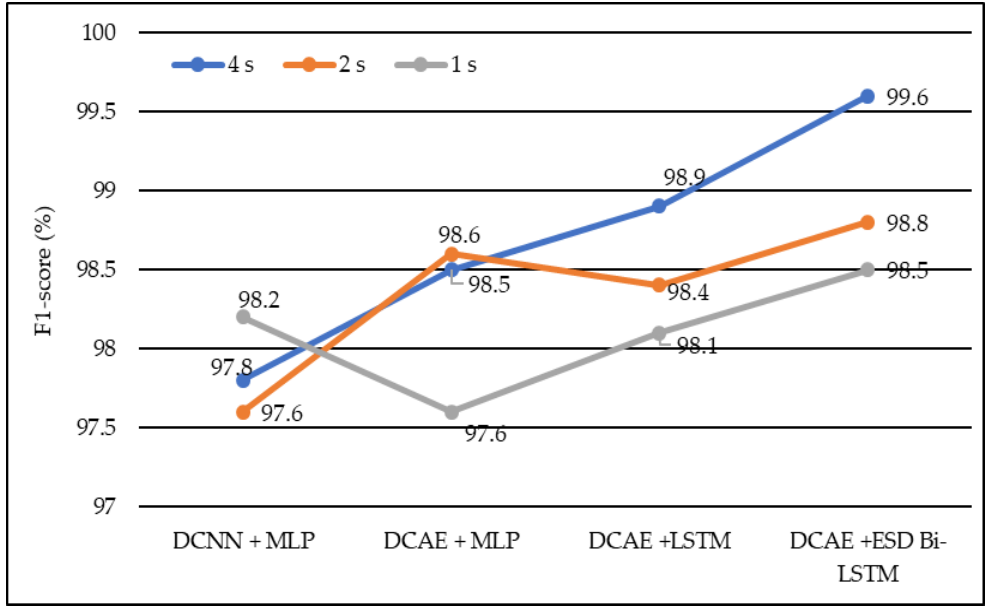
Figure 8. Average F1-score of different models using different EEG segment lengths. Loss Function and